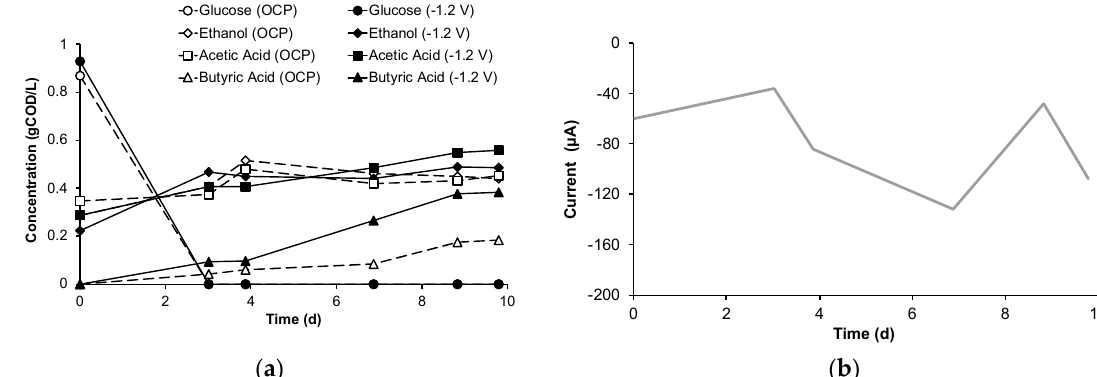
Figure 2. Time course of ( a ) mixed microbial culture (MMC) fermentation under open circuit potential (OCP) and electrofermentative (EF, − 1.2 V) conditions and ( b ) current in the EF test.